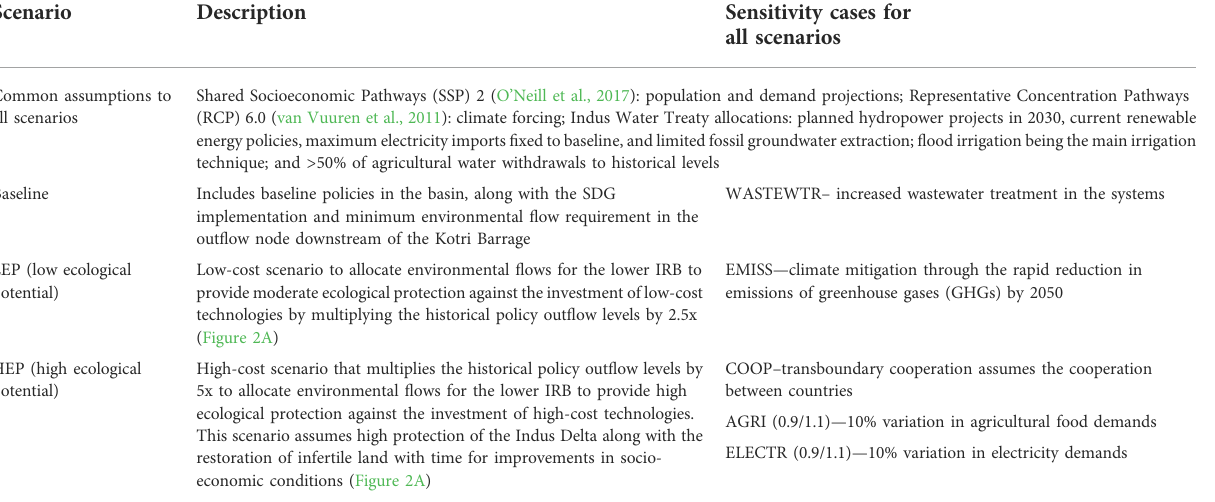
TABLE 1 Scenario layout and description of sensitivity scenarios. Scenario Description Sensitivity cases for